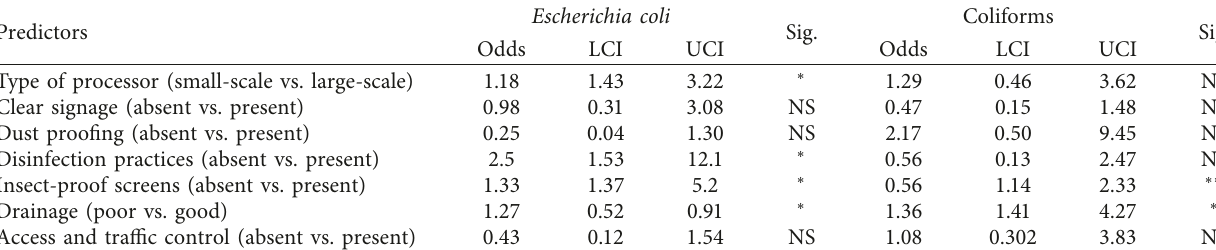
Table 2: Odds ratio estimate and lower (LCI) and upper confidence interval (UCI) of cultured buttermilk from processors with features which are not in adequate conditions having E. coli or